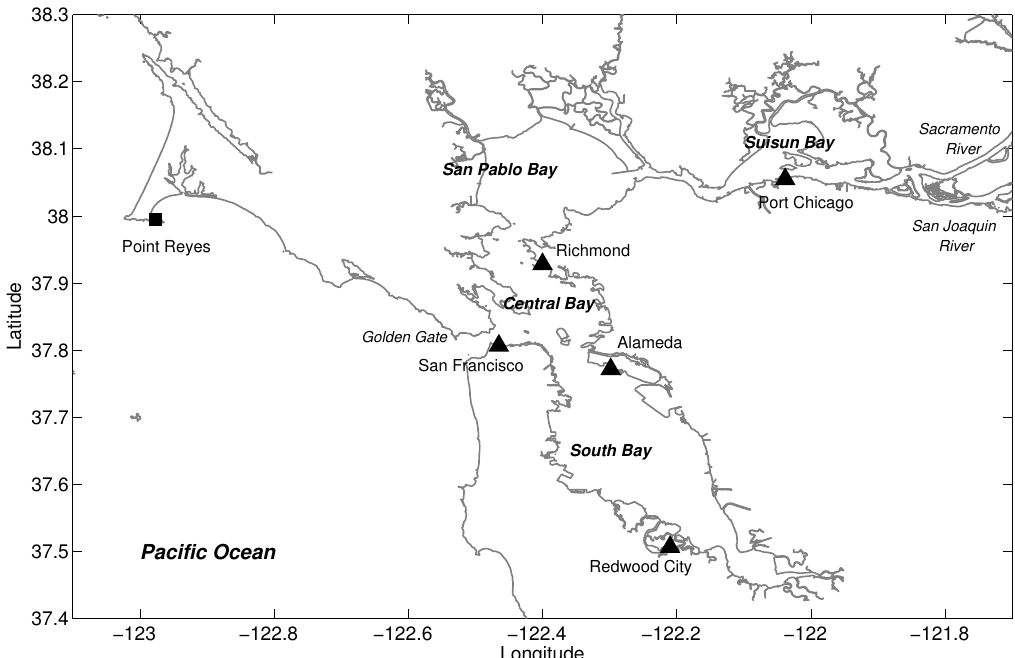
Figure 5. San Francisco Bay coastlines along with the locations of wind stations (black triangles) and the tidal gauge (black